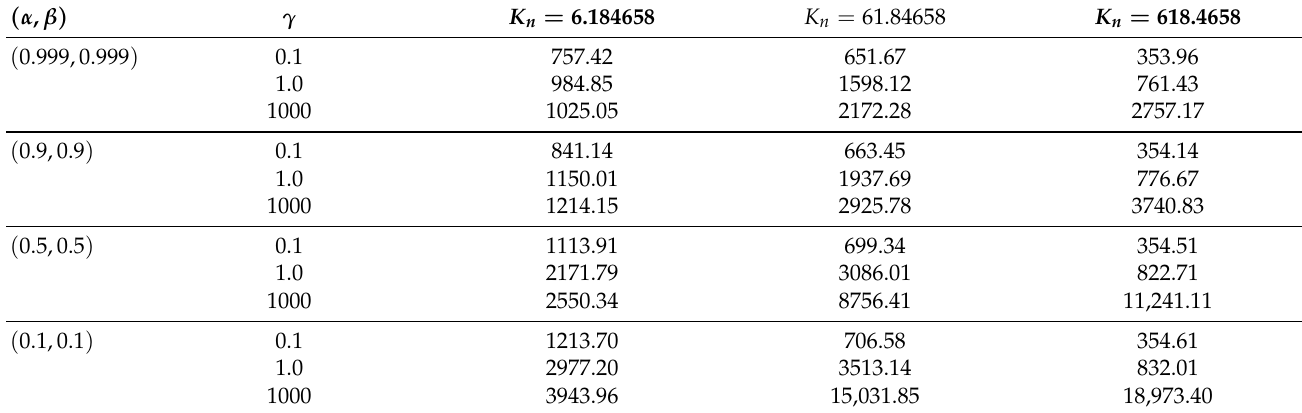
Table 10. ( T e ) max with different K n , γ , α and β ( α = β ) for Example 2.